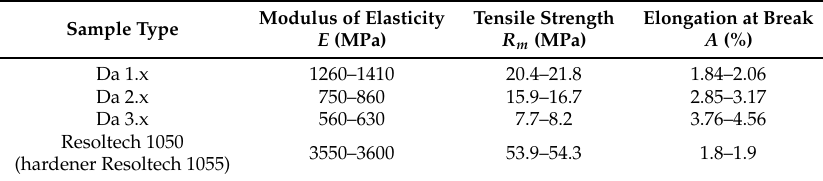
Table 1. The value limits of the modulus of elasticity, tensile strength, and elongation at break for the hybrid resin samples.